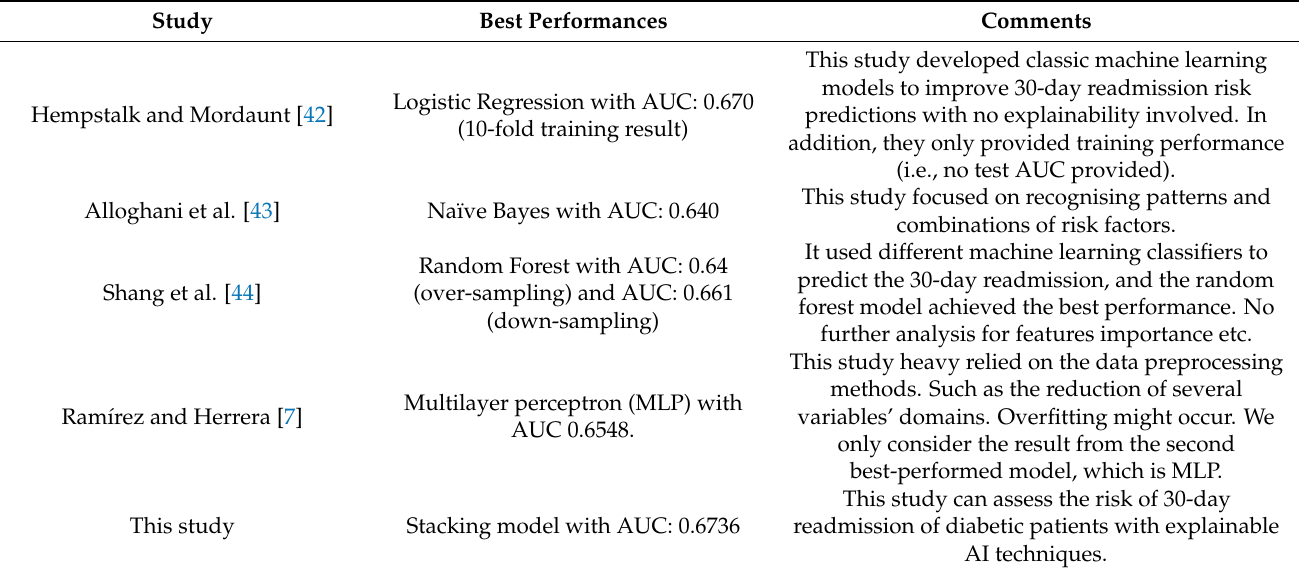
Table 4. Comparison of this study to other similar studies in the current literature using the same dataset.